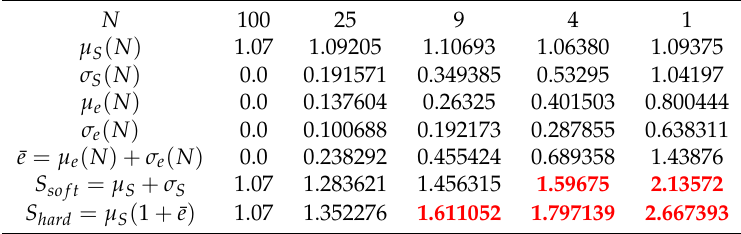
Table 1. Evaluation of the average trap count on coarse sampling grids. Analysis of the evaluation accuracy for the slug distribution from data taken in the Oadby field on 02 September 2016. The mean value µ S ( N ) and the standard deviation σ S ( N ) are computed for the average trap count S c on a sequence of quasi-regular grids with number N of sampling locations. For any realisation of the average trap count the error (2) is computed. Given K realisations of error (2), the mean evaluation error µ e ( N ) , the standard deviation σ e ( N ) of the evaluation error, and the upper error bound µ e ( N ) + σ e ( N ) are computed for each N in the table. The values of the estimate of the average trap count that exceed a hypothetical management action threshold of 1.5 slugs per trap (in this case, suggesting application of control measures) are shown in red. N 100